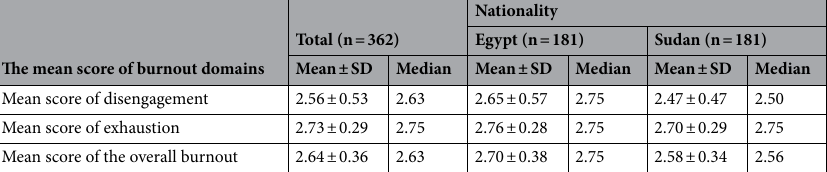
Table 2. Mean scores of burnout syndrome among healthcare professionals working at COVID-19 isolation facilities in Egypt and Sudan.